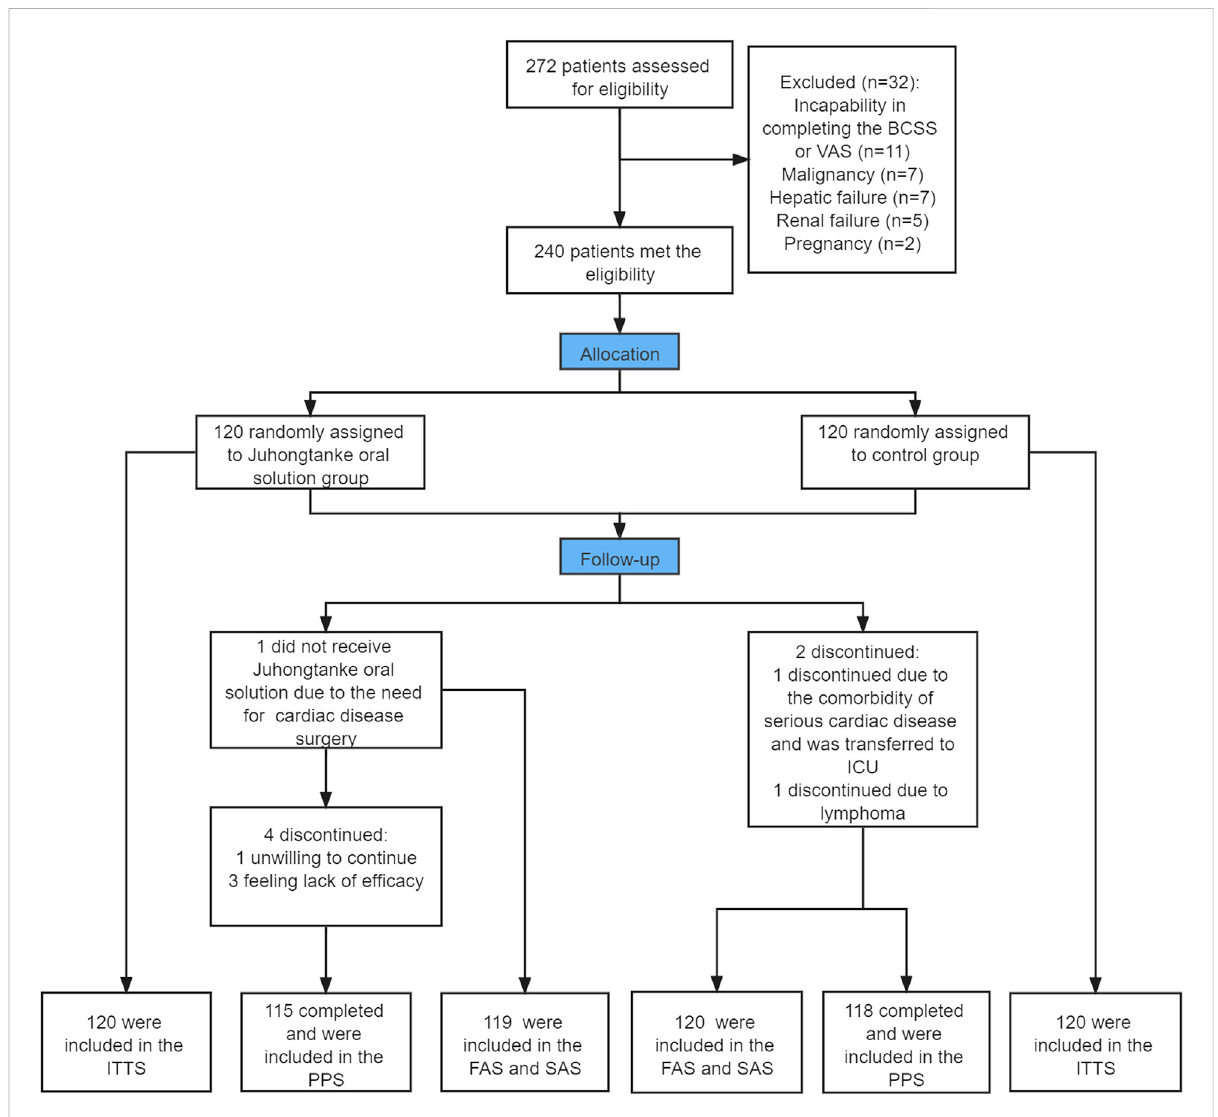
FIGURE 1 Study fl ow chart. ITTS, intention-to-treat set; FAS, full analysis set; PPS, per-protocol set; SAS, safety analysis set. BCSS, Breathlessness, Cough, and Sputum Scale; VAS, Visual Analogue